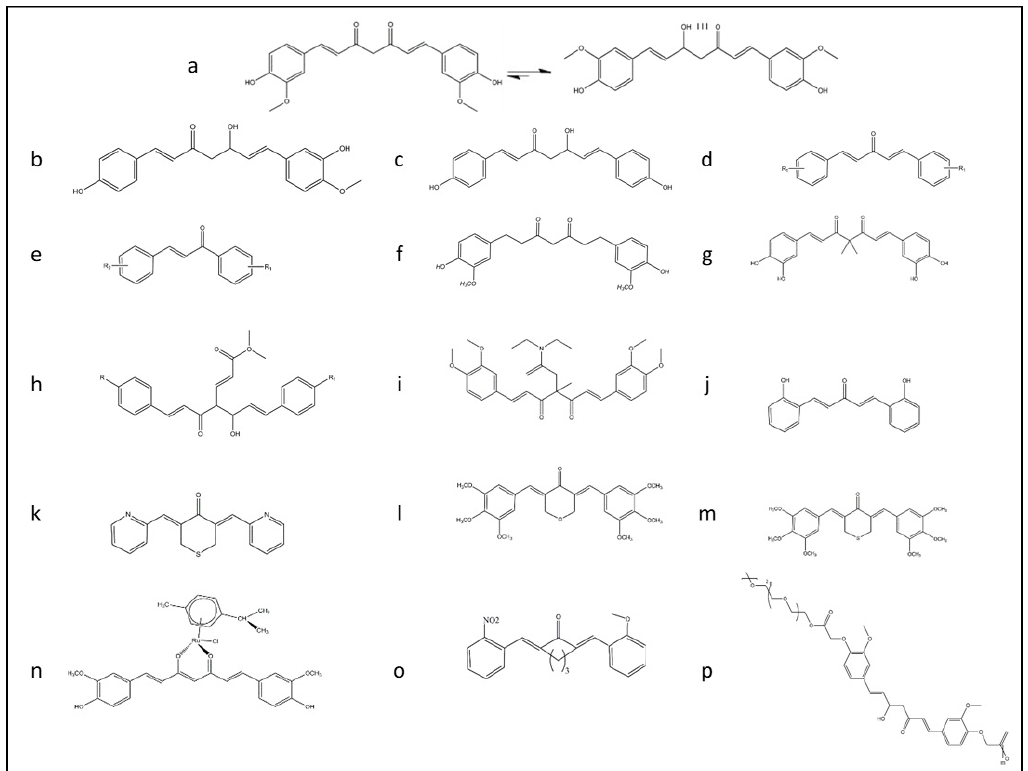
Figure 1. The rational design of derivative of curcumin for improving the bioavailability of this structure and promoting Nrf2 signaling pathway summarized in this figure. ( a ) Keto-enol form of curcumin structure. ( b ) Deoxymethylcurcumin. ( c ) Bisdeoxymethylcurcumin. ( d ) 5-carbon enone spacer analog of curcumin. ( e ) 3-carbon enone spacer analog of curcumin. ( f ) Tetrahydrocurcumin analog. ( g ) Curcumin analog with the geminal dimethyl groups and the catechol moiety. ( h ) Fumarate and curcumin-based analog. ( i ) TML-6 analog with modification for fix isomerization of keto form of curcumin with a methyl group and N, N-diethylacetamide. ( j ) Modified form of curcumin analog with five carbon linkages bis[2-hydroxybenzylidene] acetone (BHBA). ( k ) FN1 a synthetic analog of curcumin ((3E,5E)-3,5-bis(pyridin-2 / 3 / 4-methylene)-tetrahydrothiopyran-4-one). ( l ) E10 a synthetic analog of curcumin ((3E,5E)-3,5-bis-(3,4,5-trimethoxy-benzylidene)-tetrahydropyran-4-one). ( m ) F10 a synthetic analog of curcumin ((3E,5E)-3,5-bis-(3,4,5-trimethoxybenzylidene)-tetrahydro-thiopyran-4-one). ( n ) Ruthenium (II)-curcumin compound. ( o ) A13 a synthetic analog of curcumin (2,6-bis((3-methoxy-4-hydroxyphenyl) methylene)-cyclohexanone). ( p ) PEGylated analog of curcumin.